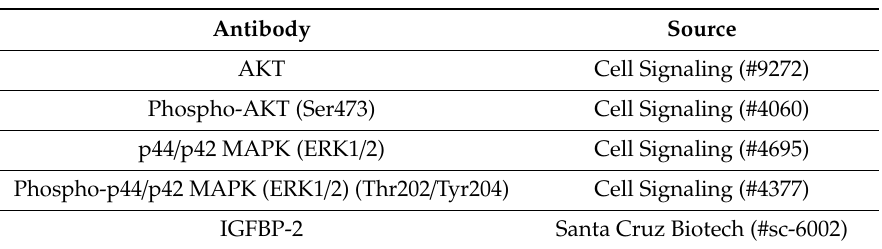
Table 1. Antibodies used for the analysis of signal transduction in muscle